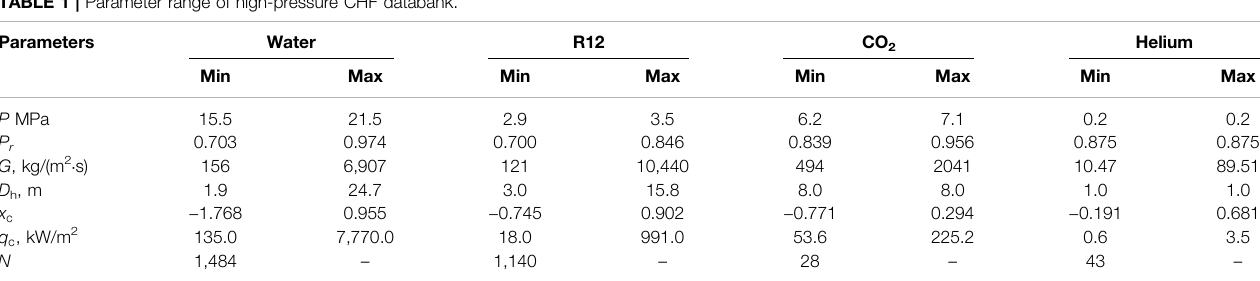
TABLE 1 | Parameter range of high-pressure CHF databank.